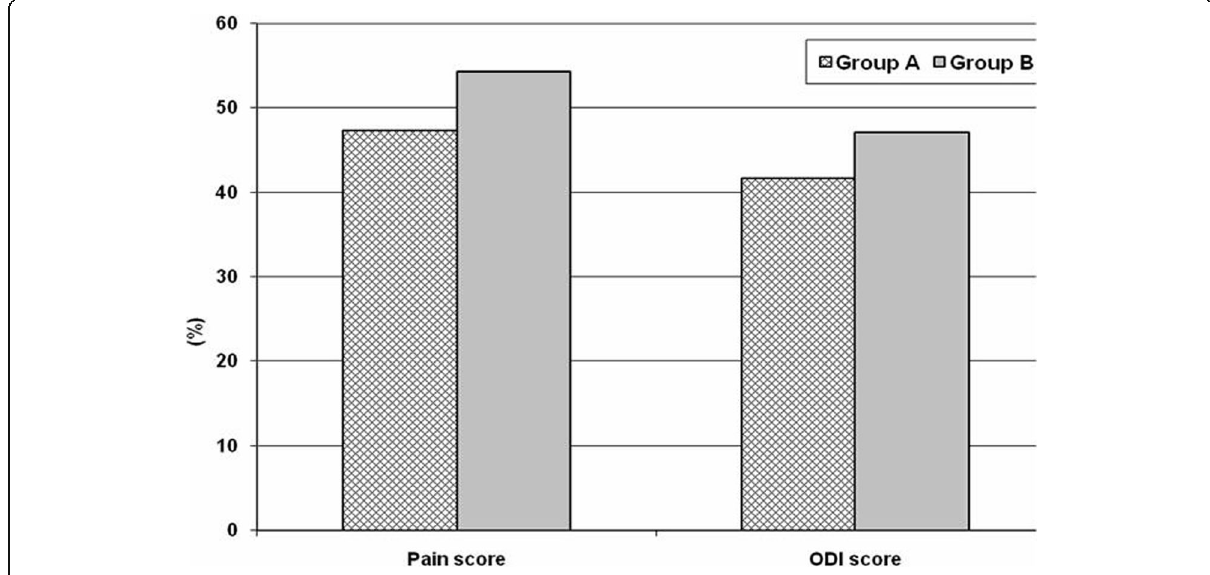
Fig. 7 Mean percentage of improvement of pain and ODI score at 6 months post-operative in patients of both groups